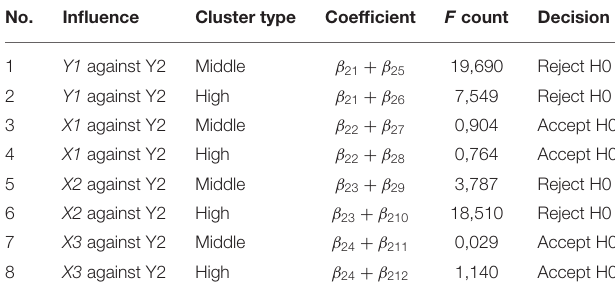
TABLE 10 | HFLP indirect